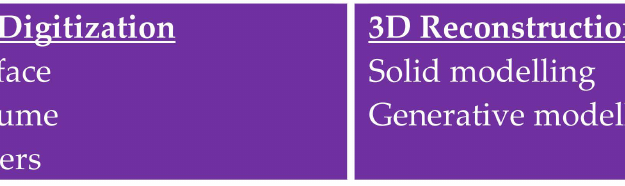
Figure 13. Chapter